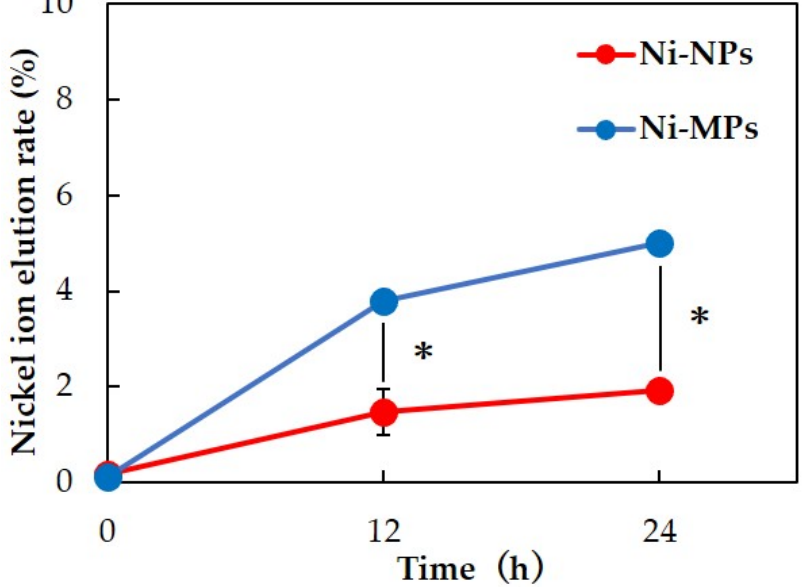
Figure 2. Comparison of nickel ion elution rate over time for each particle dispersion. Data are presented as the mean ± S.D., * denotes statistical significance p < 0.05.